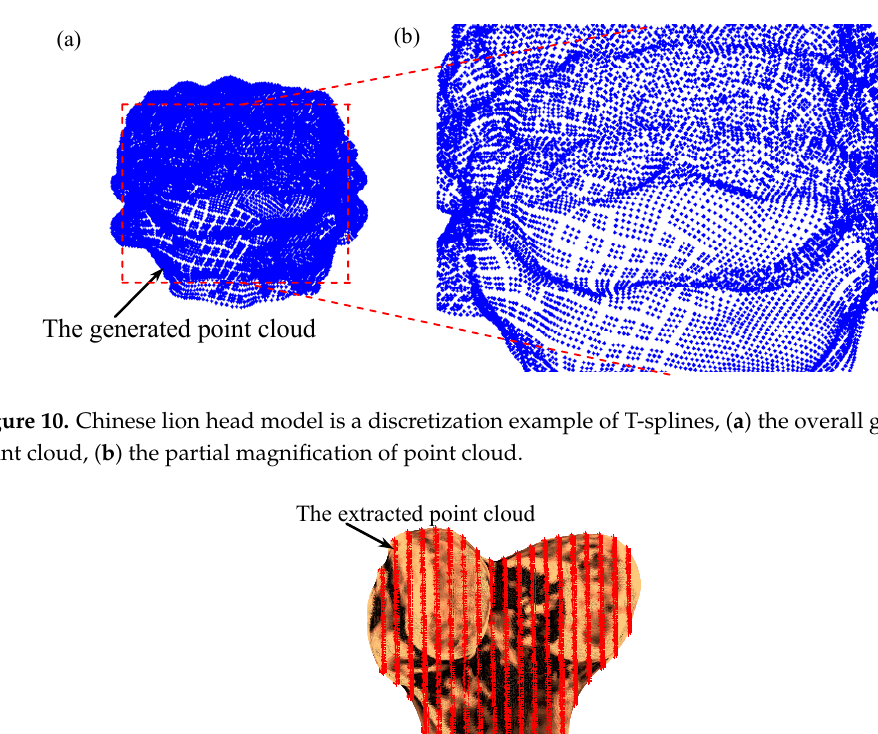
Figure 9. Knee bone model is a discretization example of T-splines, ( a ) the overall generated point cloud, ( b ) the partial magnification of point cloud.